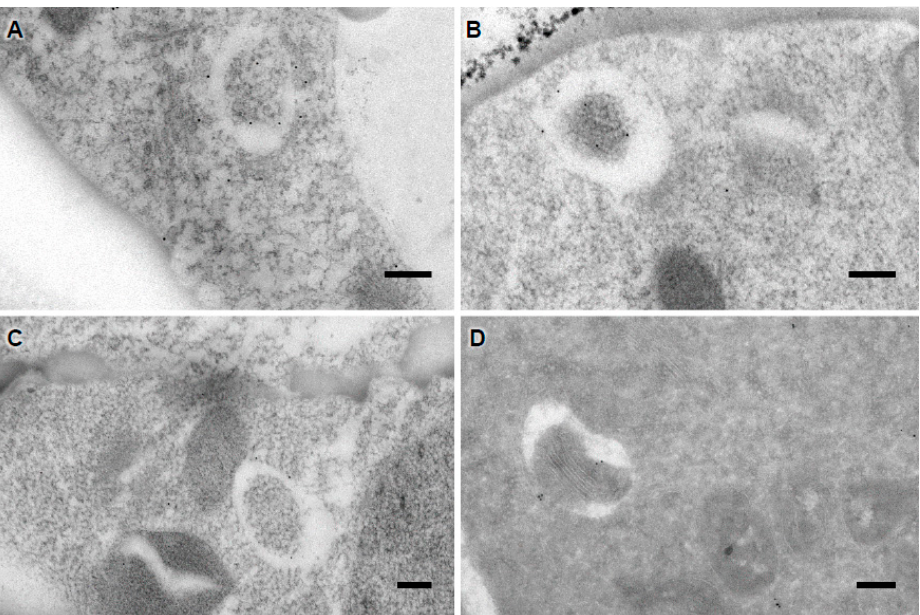
Figure 6. Immunolocalization of ATG8 protein. ( A – C ) Plants expressing a GFP-ATG8 construct were included in glycol methanlacrylate acrylic (GMA) resin as described in [40]. Then, 80 nm sections were collected on a nickel grid and immunolabeling was performed with an antibody against GFP; ( D ) Cryosections of Arabidopsis roots expressing GFP-ATG8 and decorated using anti-GFP antibodies. Scale bars: 5 µm.